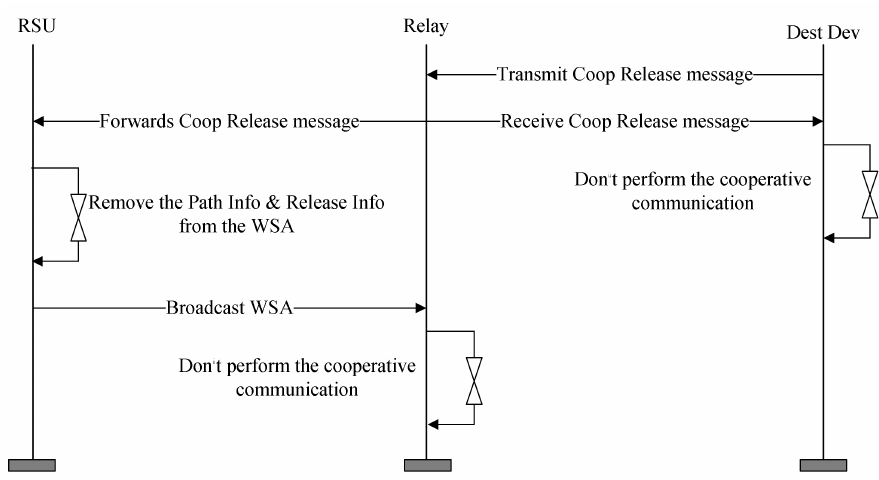
Figure 13. The timing diagram for the exchange of the control message for the resource release.